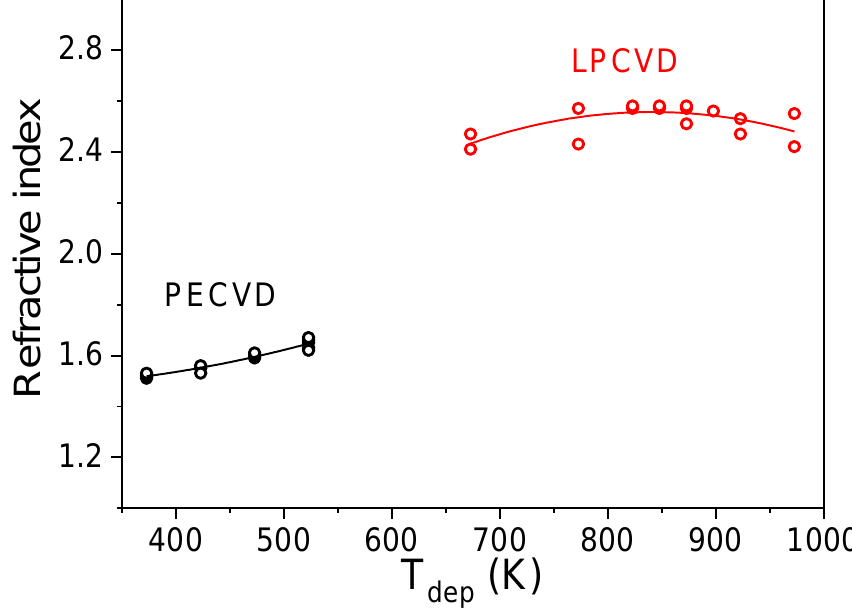
Figure 10. Refractive index of BC x N y films as a function of the deposition temperature and CVD process type.